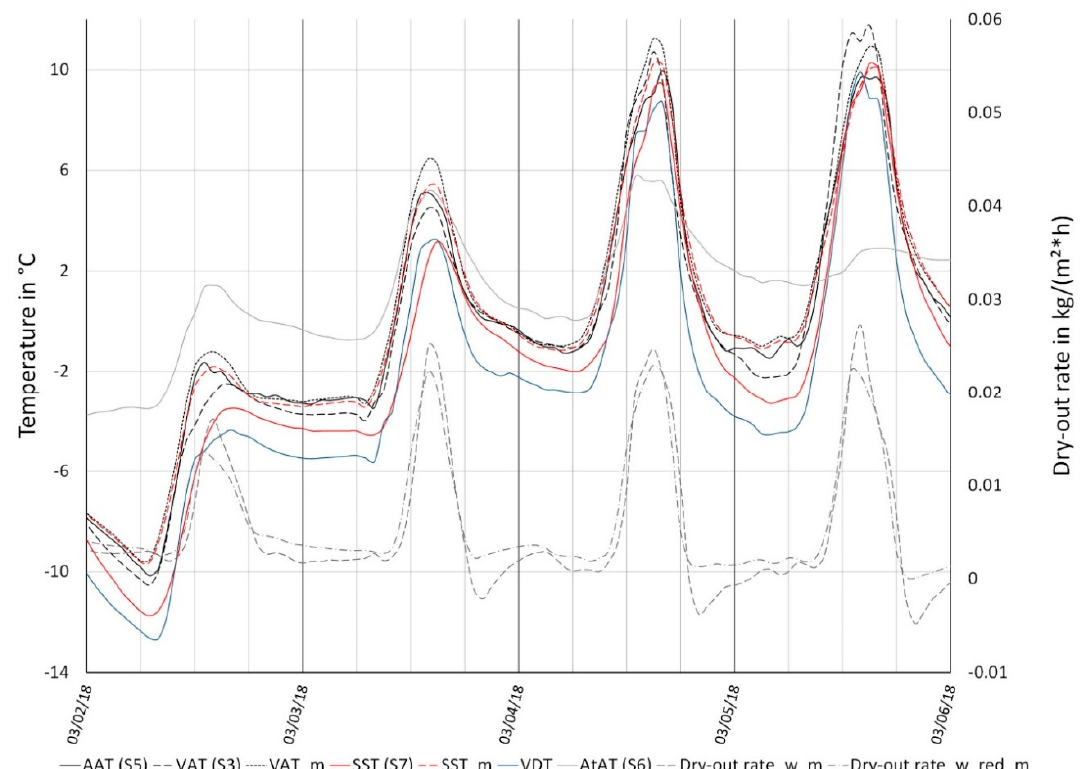
Figure 7. Various temperatures and dry-out rates of the lower shingle layer in the beginning of March 2018.